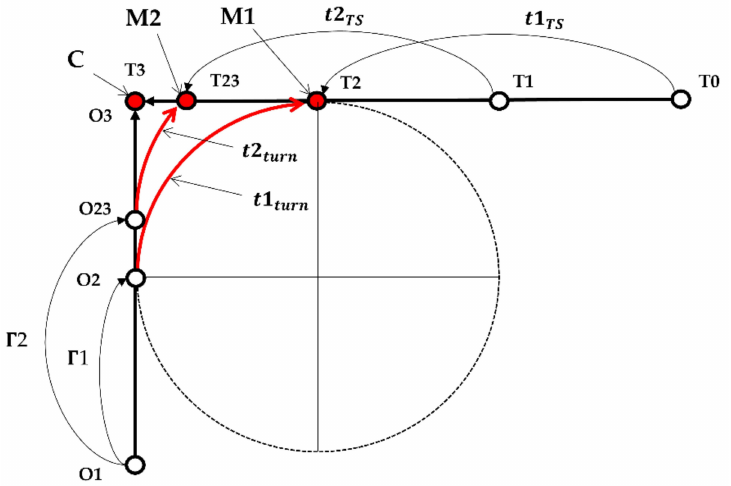
Figure 2. Concept for estimating a critical